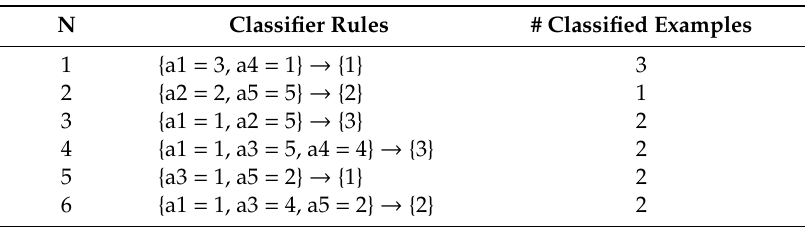
Table 4. Final classifier.